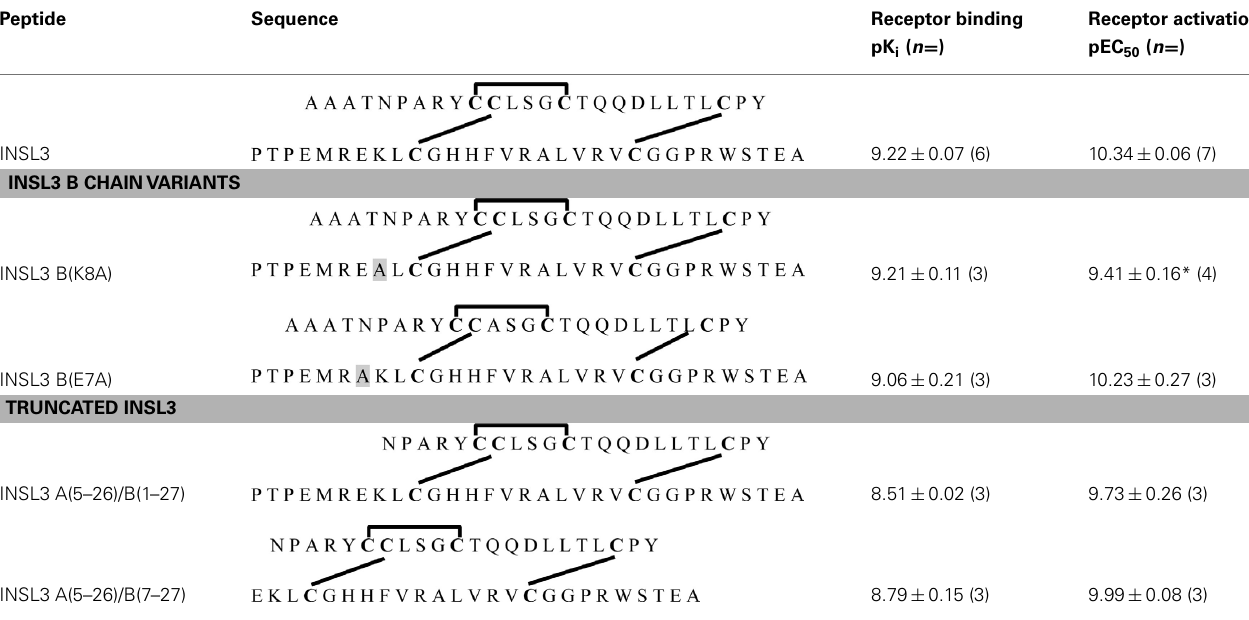
Table 3 | Sequences and receptor binding affinities (pKi) and receptor activation (pEC50) activities of INSL3, INSL3 B chain variants, and truncated INSL3